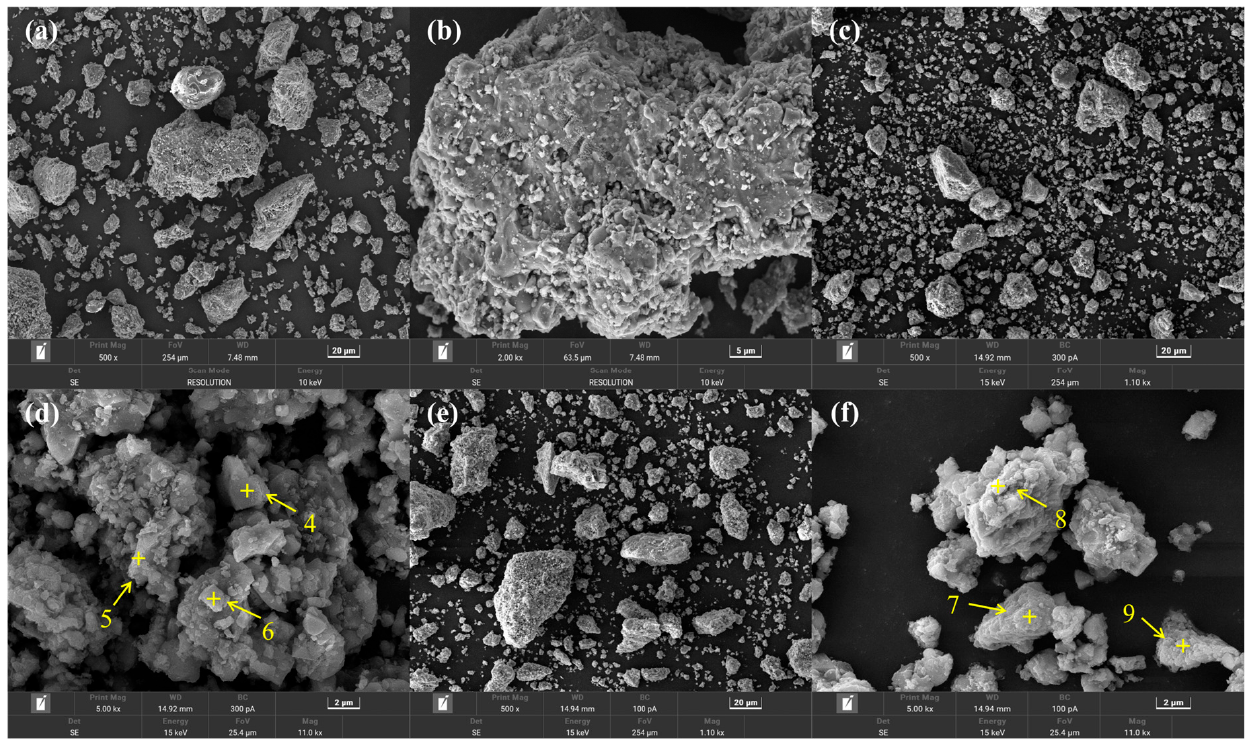
Figure 13. SEM images of the sintered red mud ( a , b ); leaching red mud ( c , d ); and magnetic separation product( e , f ) with magnifications from 500 × to 5k × ; The yellow numbers (4–9) in the subfigures ( d , f ) corresponding to the EDS results in the Table